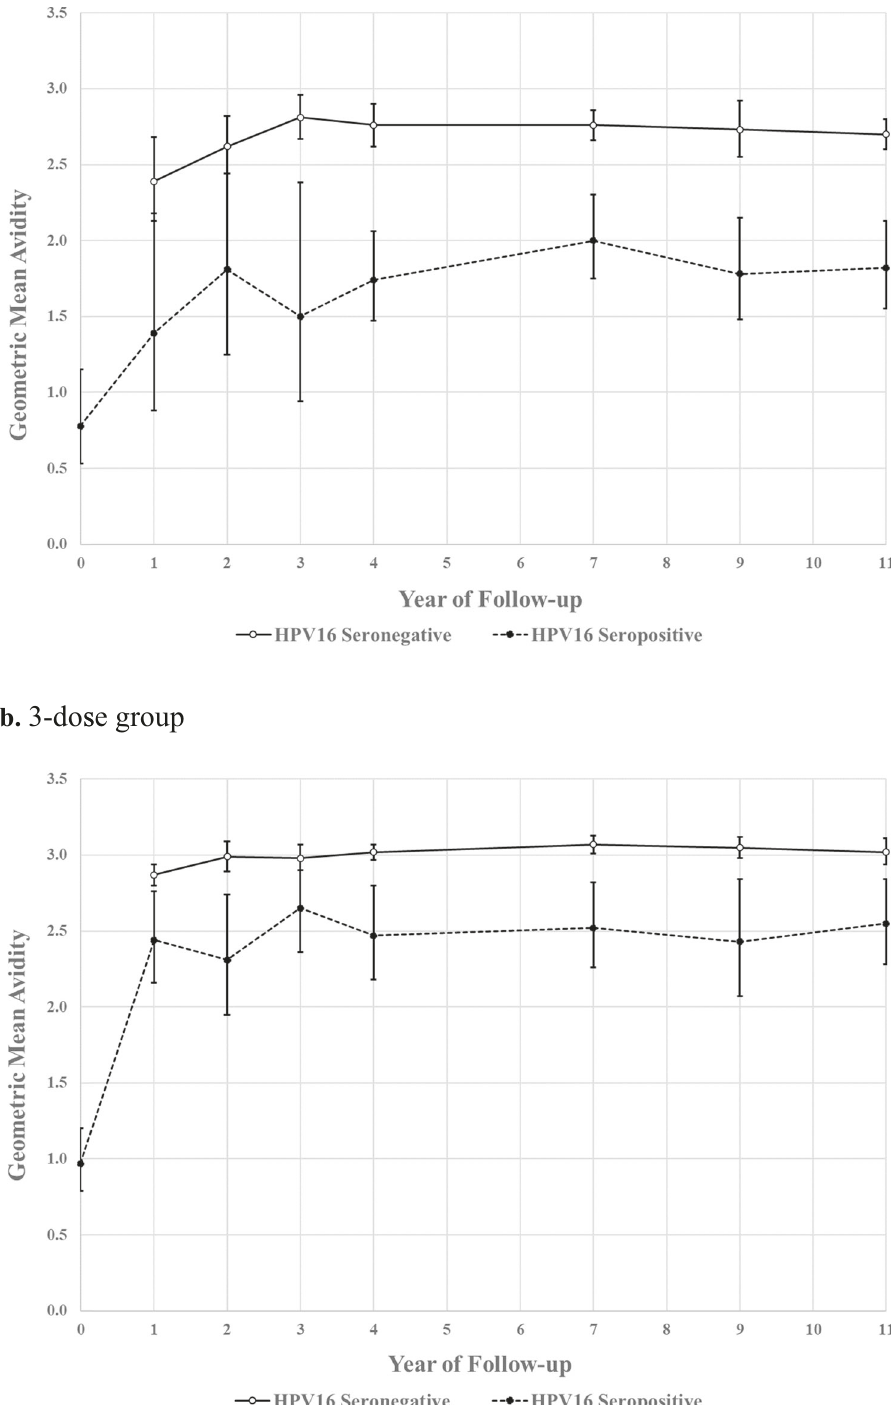
Fig. 2 HPV16 antibody avidity over time, strati fi ed by number of HPV vaccine doses received and HPV16 serostatus at time of initial HPV vaccination. HPV16-seronegative status at fi rst HPV vaccination is represented by the solid line and HPV16 seropositive at fi rst HPV vaccination is represented by the dashed line. Dots represent the geometric mean antibody avidity index for the one-dose group ( a ) and the three-dose group ( b ) and the error bars represent 95% con fi dence intervals (CI). Regression lines are estimated by regressing log(avidity) on either an intercept, an indicator for the second study visit, and/or study year, and reporting on the parameter the parameter 100(e β